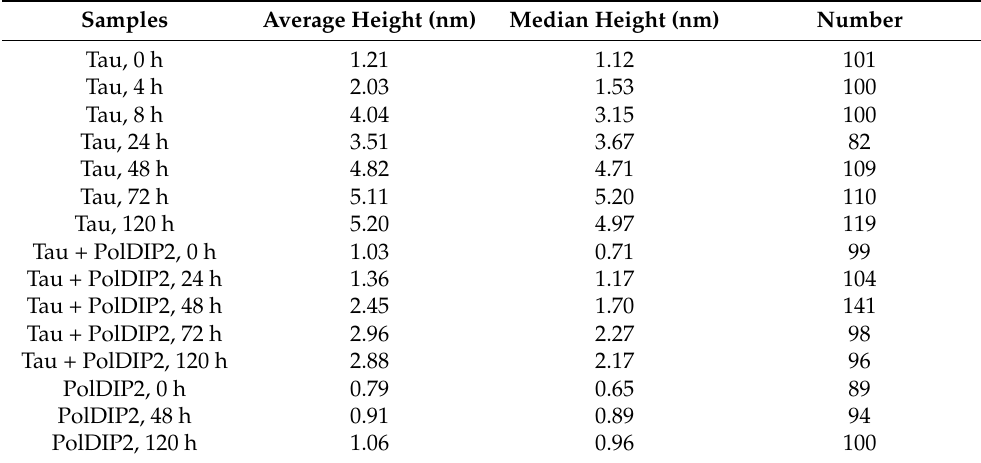
Table 1. Statistical data of the fibril height distributions for the samples presented in Figure 4.